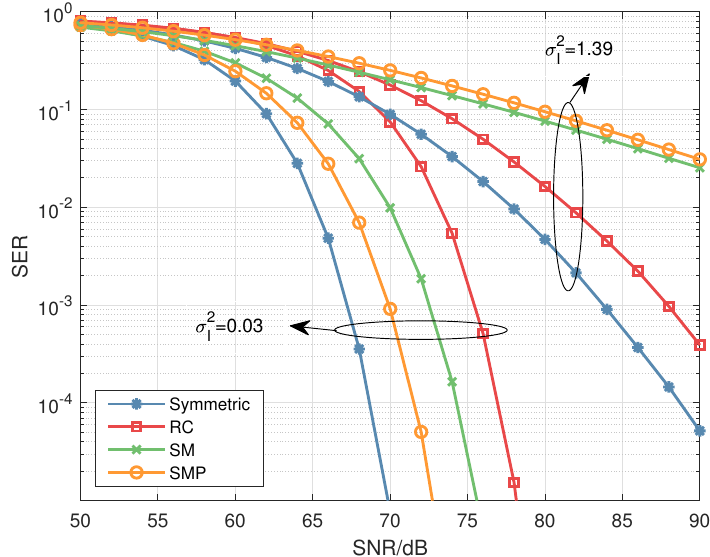
Figure 7. Reliability performance comparisons for the underwater channel.